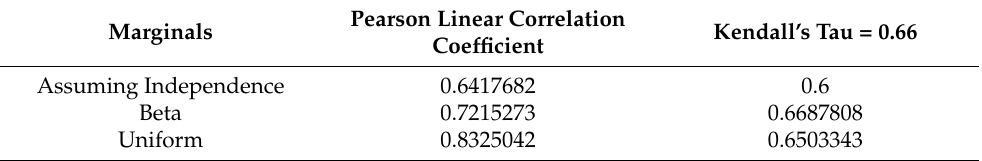
Table 4. Correlation structure of the bivariate pair HIVAIDS and non-HIVAIDS for males.